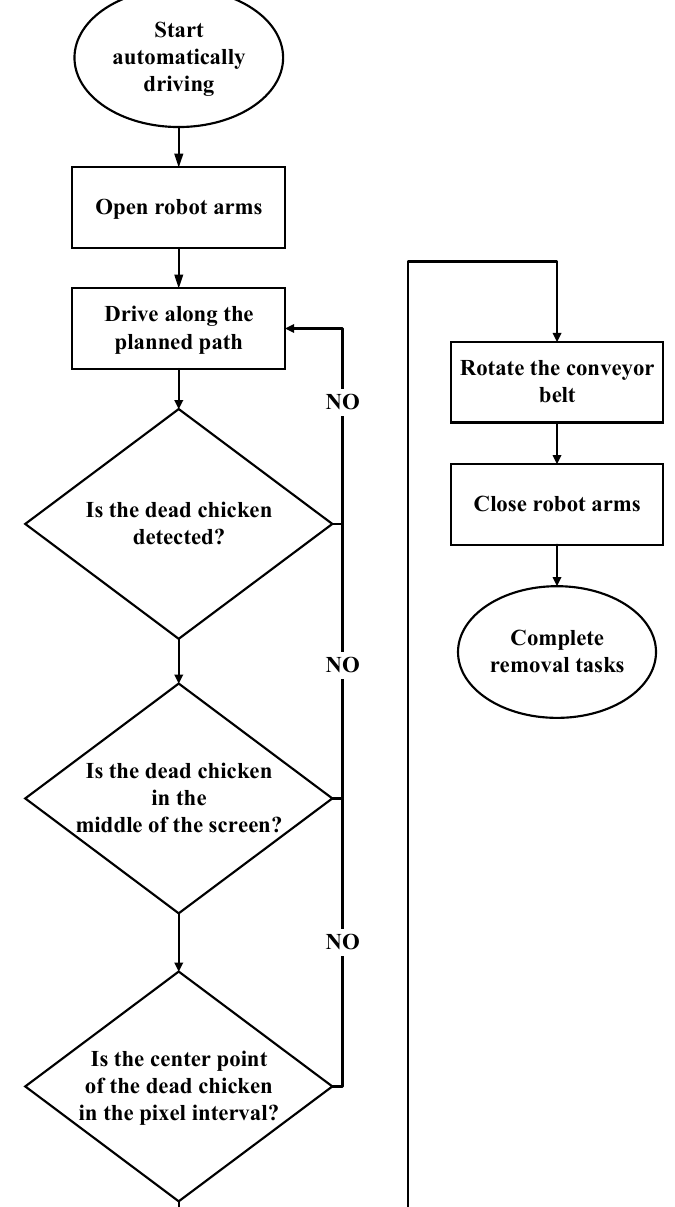
Figure 9. The functioning of the developed system in the automatic mode.